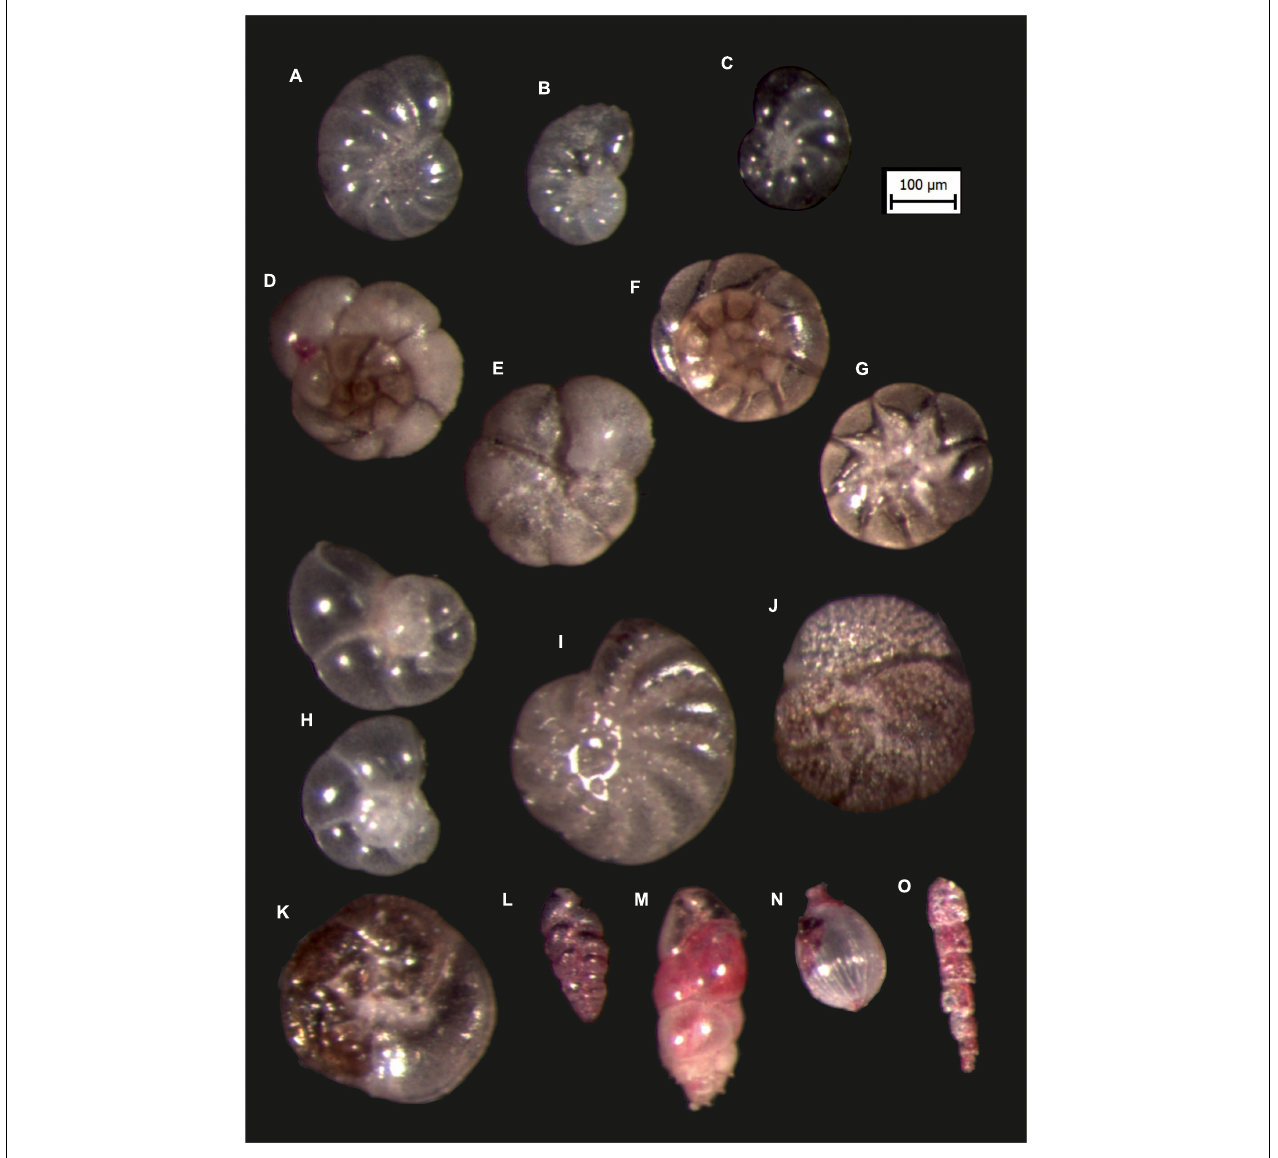
FIGURE 6 | Microphoto images (using Olympus U-TV1XC camera) of the selected foraminiferal species: (A) Haynesina depressula (Walker and Jacob, 1798), KPF1/5. (B) Haynesina depressula (Walker and Jacob, 1798), KPF1/5. (C) Haynesina depressula (Walker and Jacob, 1798), KPF2/5. (D) Ammonia tepida (Cushman, 1926): spiral side, KPF1/2, (E) Ammonia tepida (Cushman, 1926): umbilical side, KPF1/2. (F) Ammonia parkinsoniana (d’ Orbigny, 1839): spiral side, KPF1/2. (G) Ammonia parkinsoniana (Cushman, 1926): umbilical side, KPF1/2. (H) Aubignyna perlucida (Heron-Allen and Earland, 1913): KPF2/2. (I) Elphidium sp., non-keeled, KPF1/4. (J) Rosalina bradyi (Cushman, 1926): spiral side, KPF1/1. (K) Rosalina bradyi (Cushman, 1926): umbilical side, KPF1/1. (L) Bolivina variablis (Williamson, 1858), KPF1/5. (M) Bulimina elongata , d’ Orbigny, 1826, KPF1/3. (N) Lagena striata (d’ Orbigny, 1839), KPF1/3. (O) Reophax sp.,